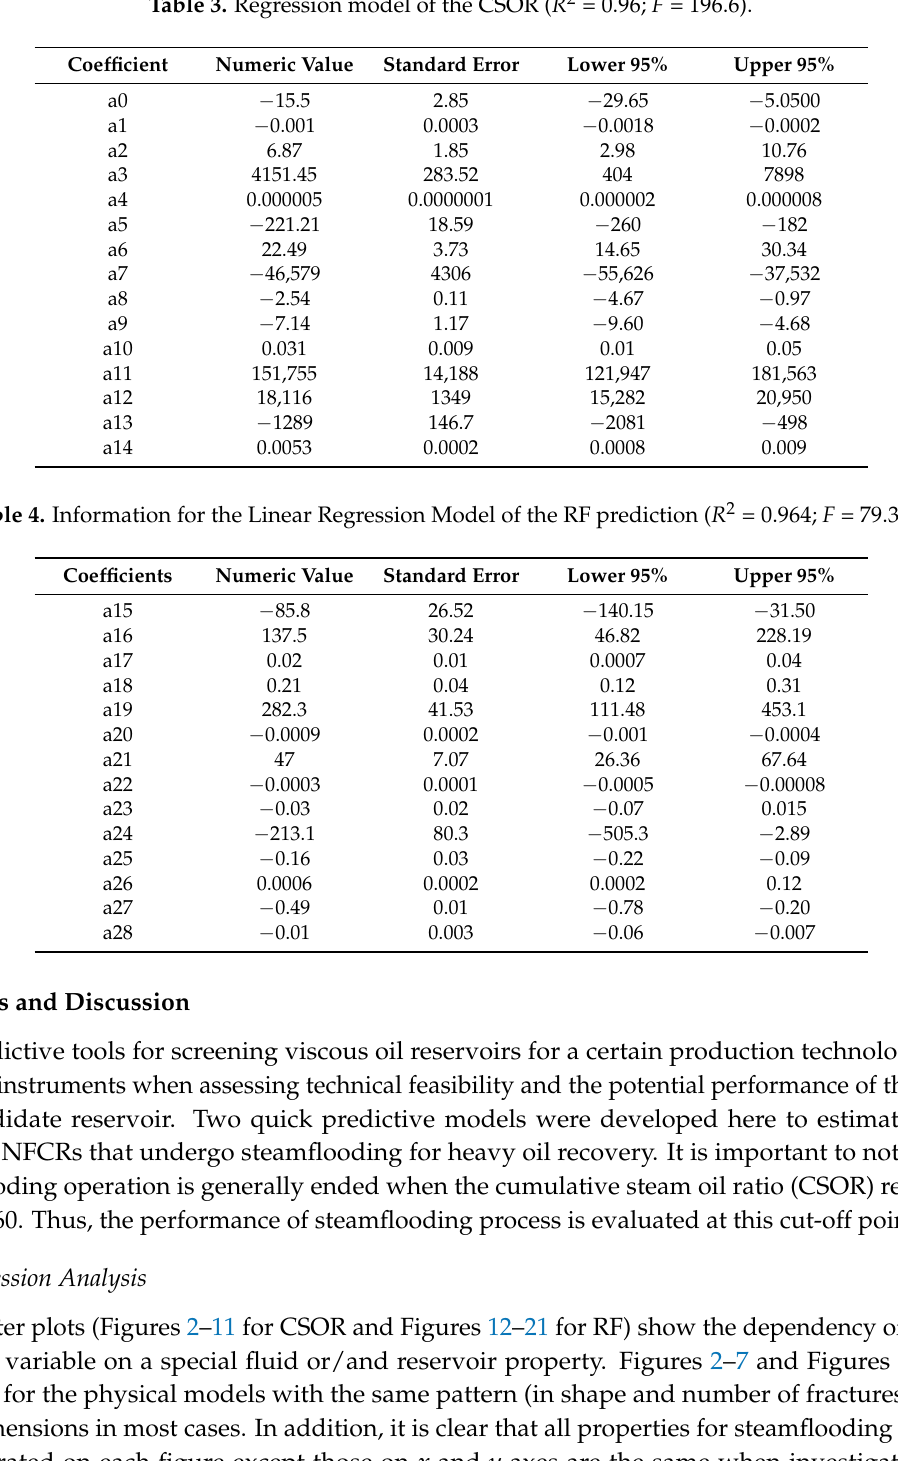
Table 3. Regression model of the CSOR ( R 2 = 0.96; F = 196.6).